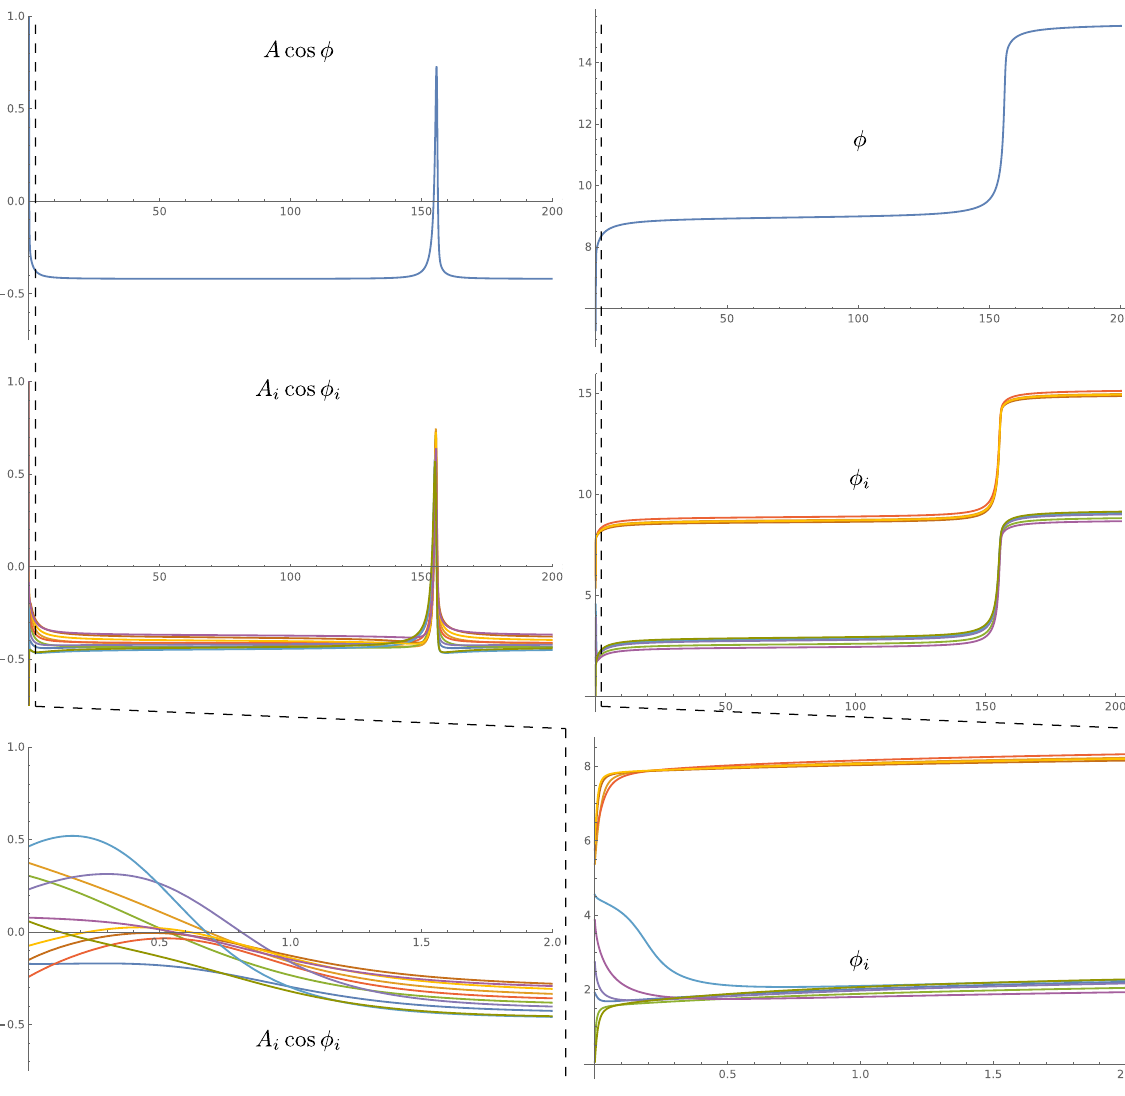
(cid:31) the derivatives is not just large, but strictly speaking they are not defined. =